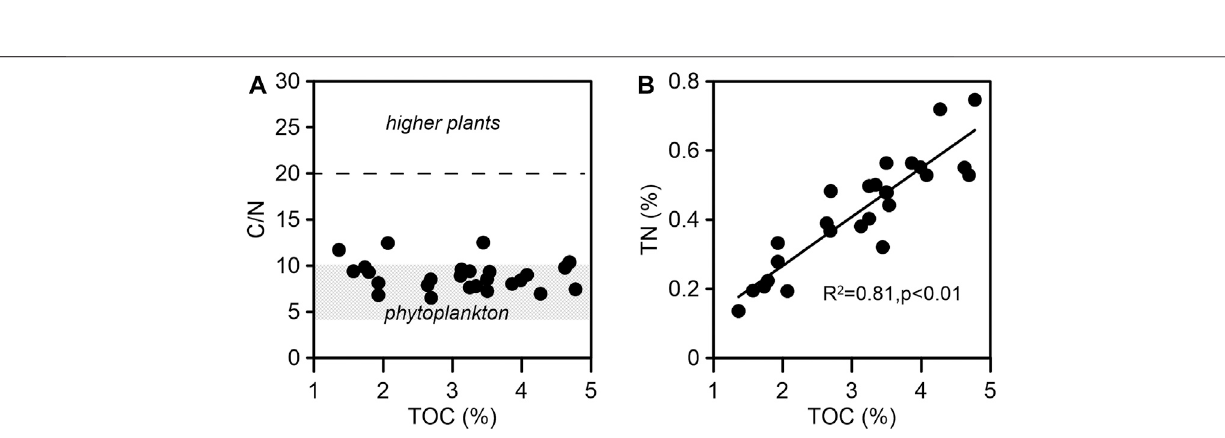
Frontiers in Earth Science |